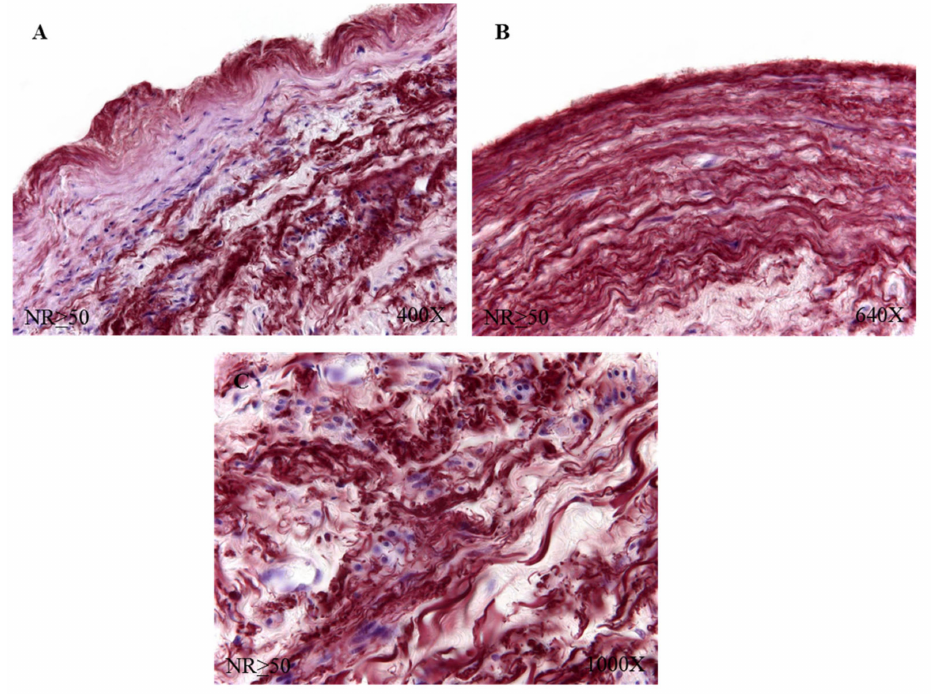
Figure 3. Images showing the elastic fibers in patients with NR ≥ 50 ( A – C